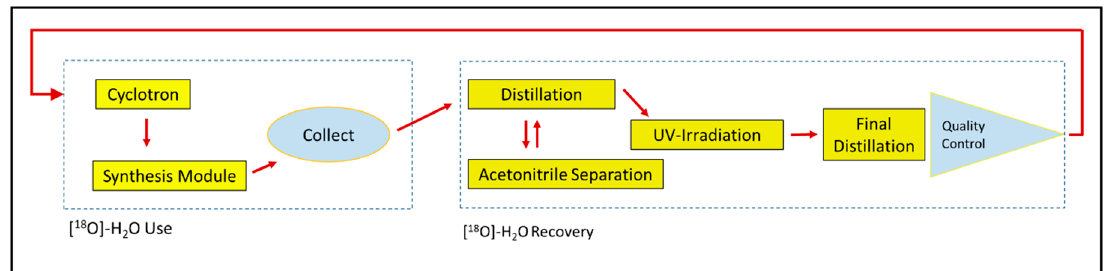
Figure 1. Overview of the optimized recovery method.